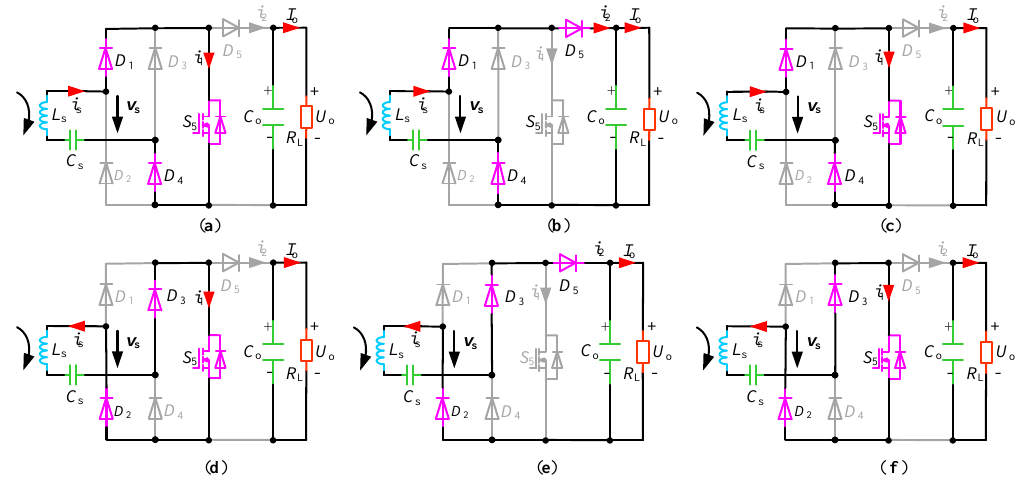
Figure 3. Operating modes of proposed receiver: ( a ) Mode 1; ( b ) Mode 2; ( c ) Mode 3; ( d ) Mode 4; ( e ) Mode 5; and ( f ) Mode 6.